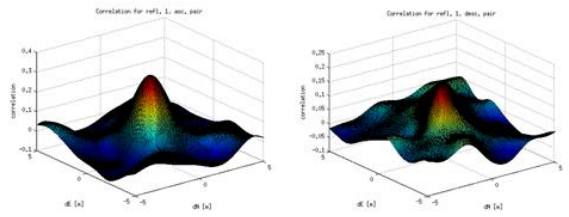
Figure 5. Correlation function for corner reflector Nr.1